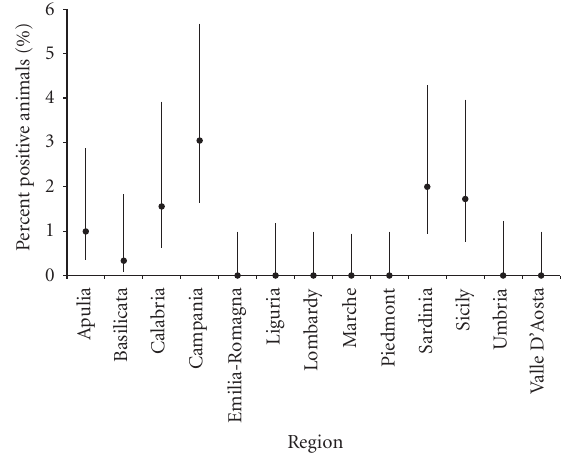
Figure 6: Percent of sera coming from the National Brucellosis Eradication Plan (NBEP, collected during year 2004) and resulted positive to RB51-CFT, on regional